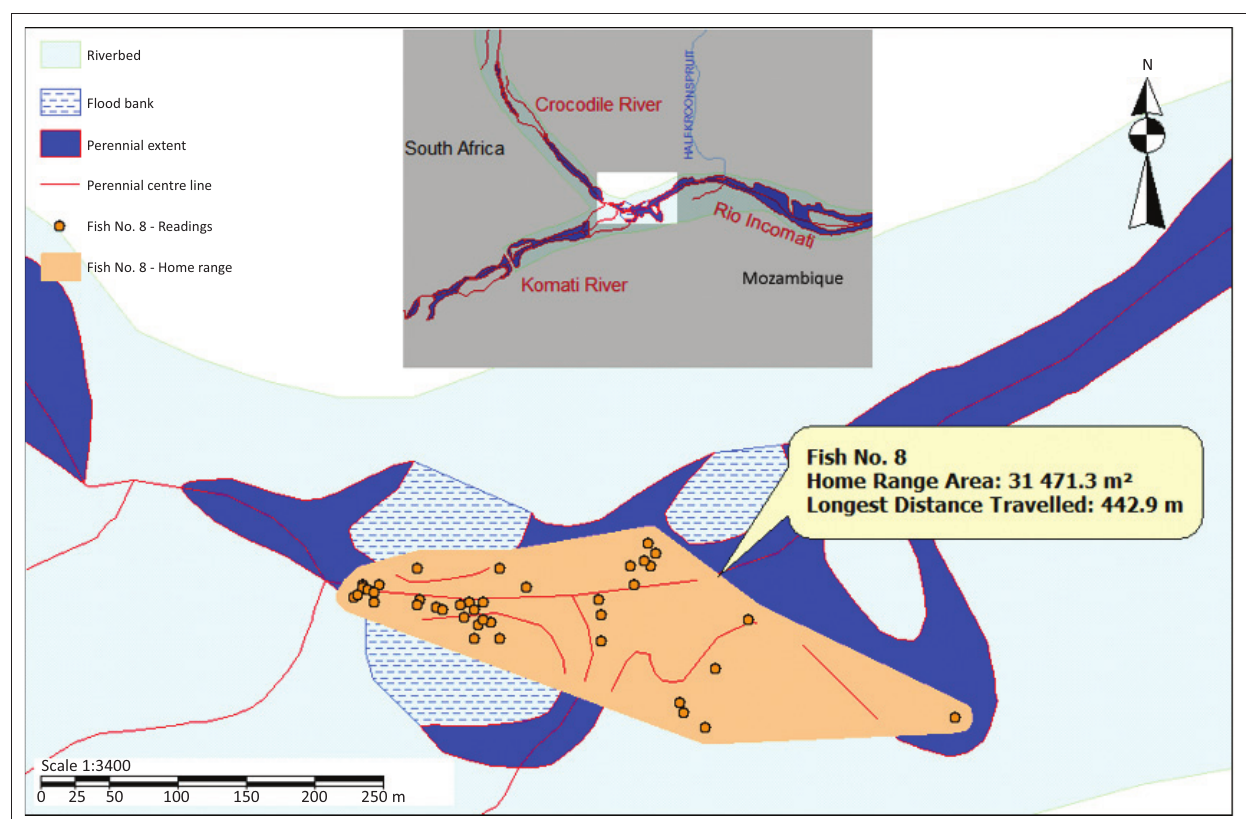
FIGURE 8: Map of radio-tagged fish number 8 indicating home range and longest distance travelled (Type 1 movement